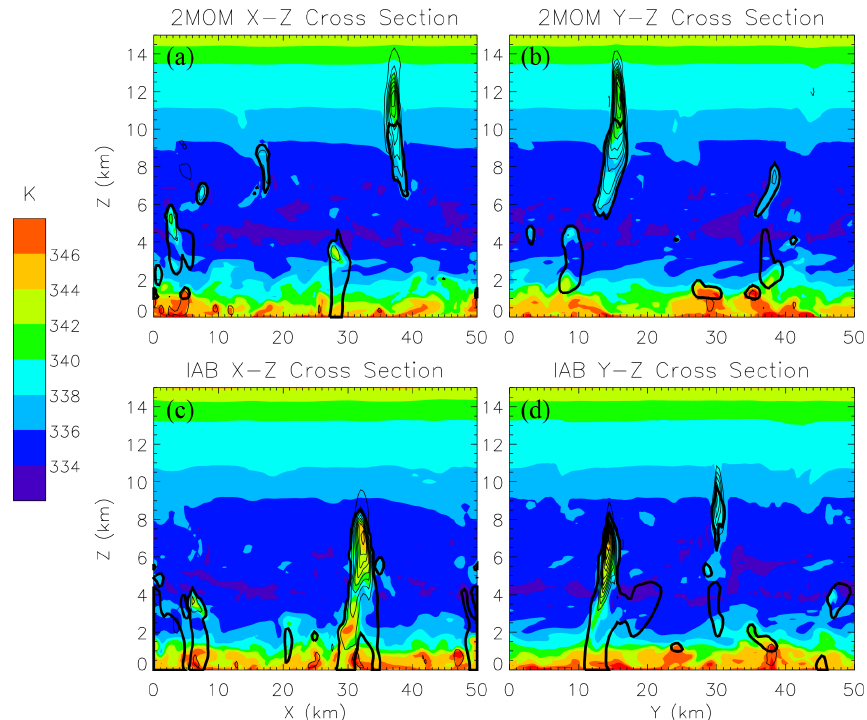
Figure 1. Cross sections ( x – z in a and c ; y – z in b and d ) though cloud simulations at 360min from (a, b) 2MOM and (c, d) IAB randomly selected ensemble members. Colors represent the equivalent potential temperature, calculated here as the moist static energy divided by c p . The thick contour shows total condensate (cloud and precipitation) of 0.1gkg − 1 . Sold thin contours show vertical velocity starting with 1ms − 1 and contour interval of 3ms − 1